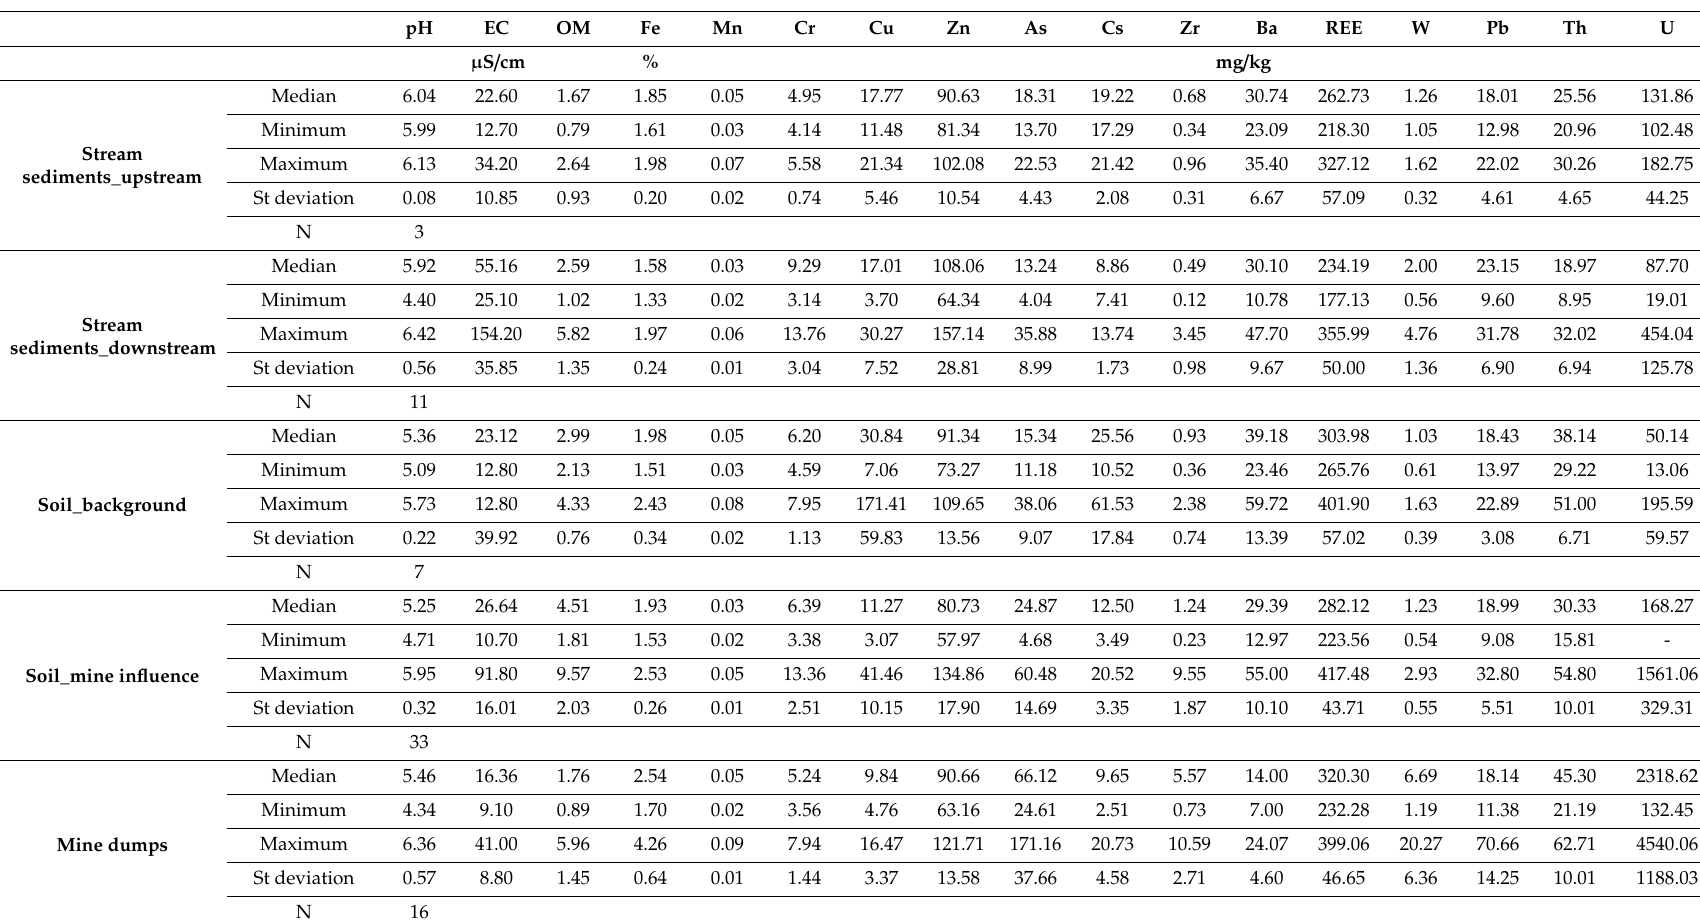
Table 2. Physicochemical, potential toxic elements, and rare earth element concentrations of stream sediments, soils, and mine dumps from Canto